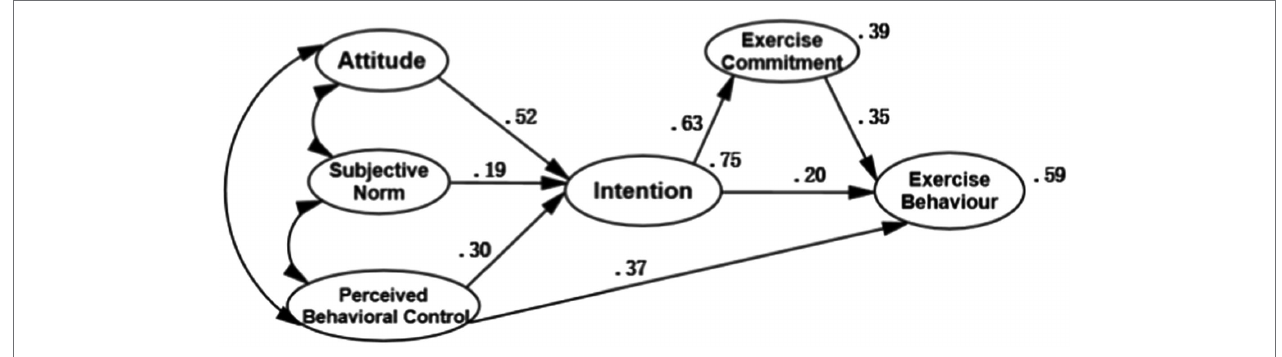
FIGURE 3 | Path coefficient diagram of structural equation model for